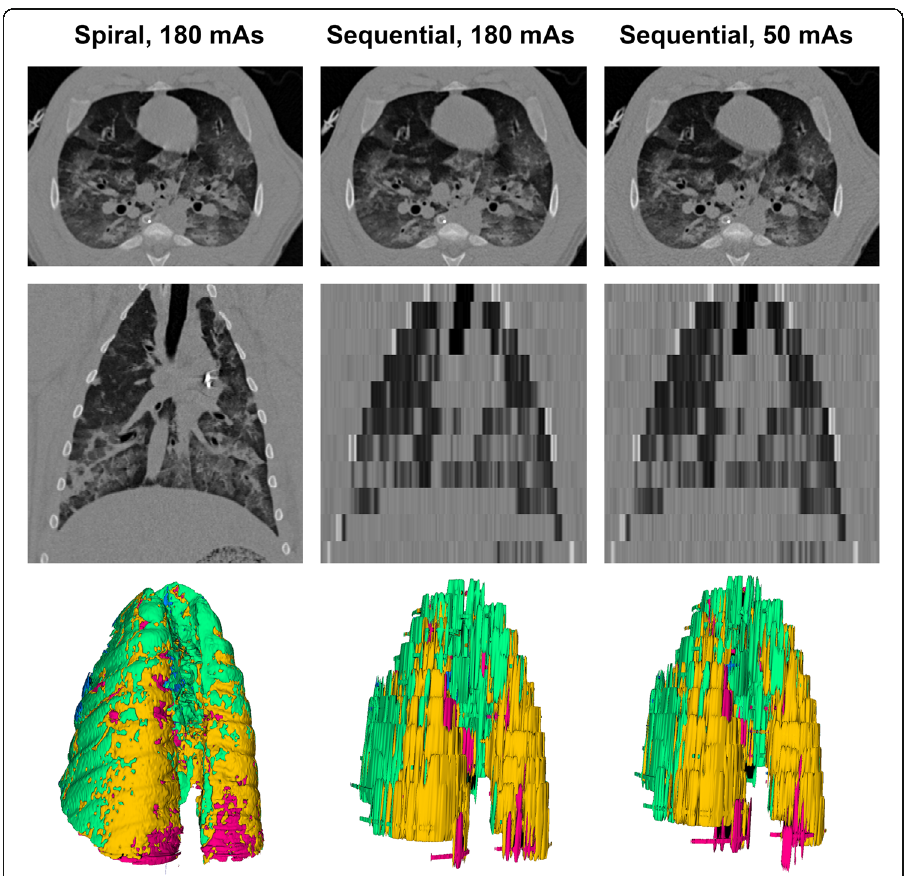
Fig. 2 Scanning protocols. Axial ( upper panels ), coronal ( middle panels ) and 3D reconstructions ( lower panels ) of the three acquisition protocols in a representative animal. Colors in the 3D reconstruction represent clusters of lung tissue: hyper-aerated ( blue ), normally aerated ( green ), poorly aerated ( yellow ), non-aerated ( red